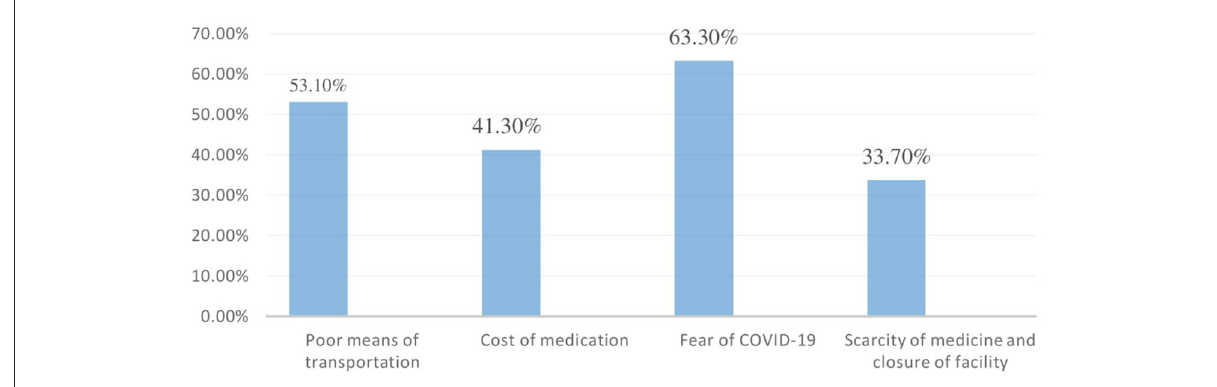
FIGURE3 The potential cause of reduced access to healthcare among adult hypertensive patients on follow-up at West Arsi public health facilities, Ethiopia, 2021.